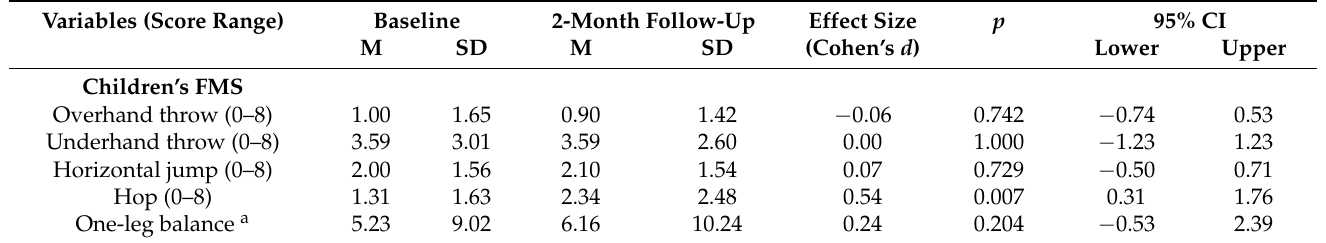
Table 4. Results from paired- samples t -tests for the mean changes in virtually assessed children’s FMS scores between baseline and 2-month follow-up (n =